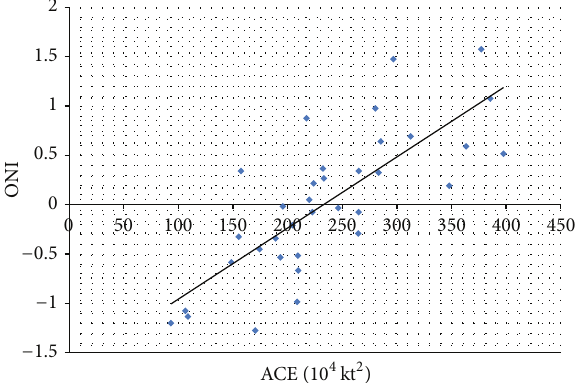
Figure 4: Relationship between ACE and ONI ( 𝑅 2 = 0.6